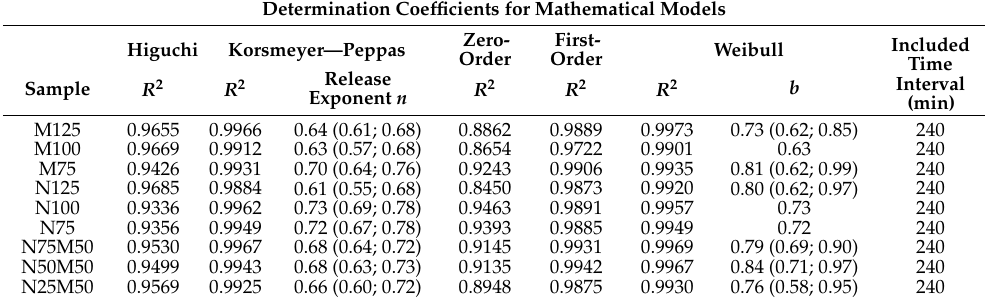
Table 6. Mathematical modelling and drug release kinetics from matrices (biorelevant dynamic